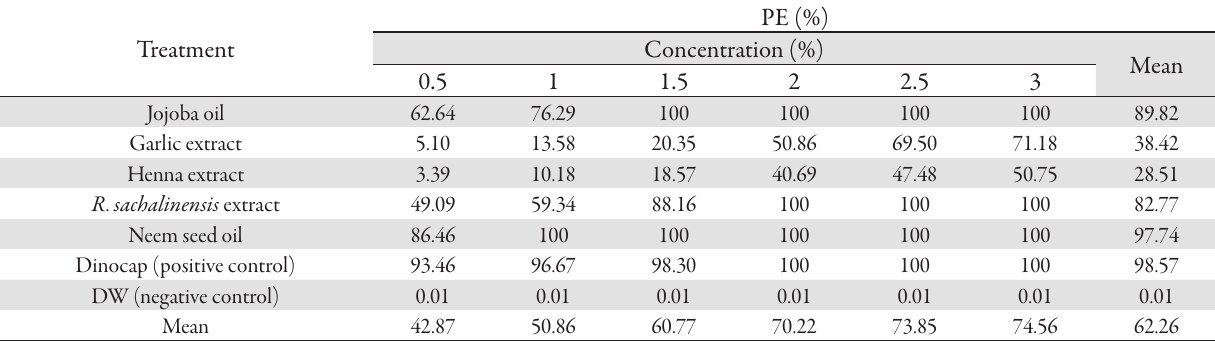
Tab. 2. Preventative effect of plant derived agents tested at different concentrations against the okra powdery mildew in the detached leaf-disc bioassay Treatment